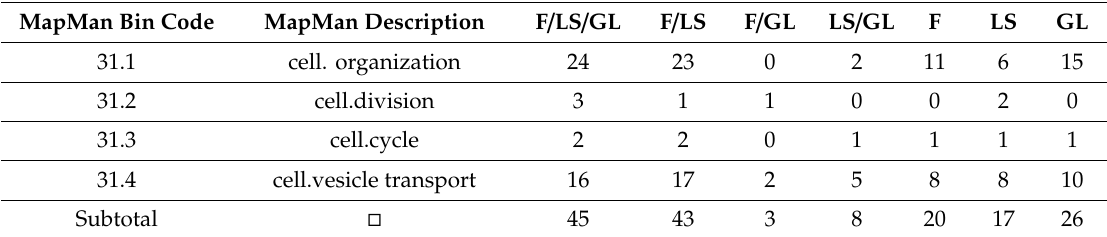
Table 2. Number of proteins, which are grouped into category “cell” using the MapMan analysis, in the flower (F), leaf sheath (LS), and green leaf (GL).